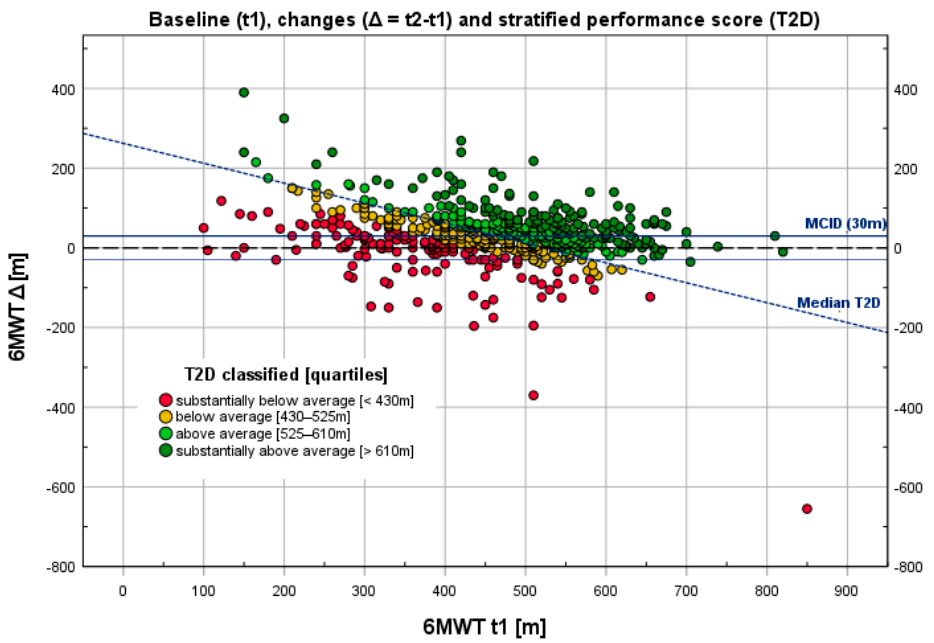
Figure 2. Relationship between changes in 6MWT ( ∆ : t2 − t1) relative to baseline (t1) and stratified performance scores (T2D). A total of 575 patients with COPD were evaluated through the six-minute walking test (6MWT) before (t1) and after (t2) outpatient pulmonary rehabilitation. There is a negative correlation ( r = − 0.30, p < 0.001 ***) between the baseline (abscissa) and changes (ordinate).